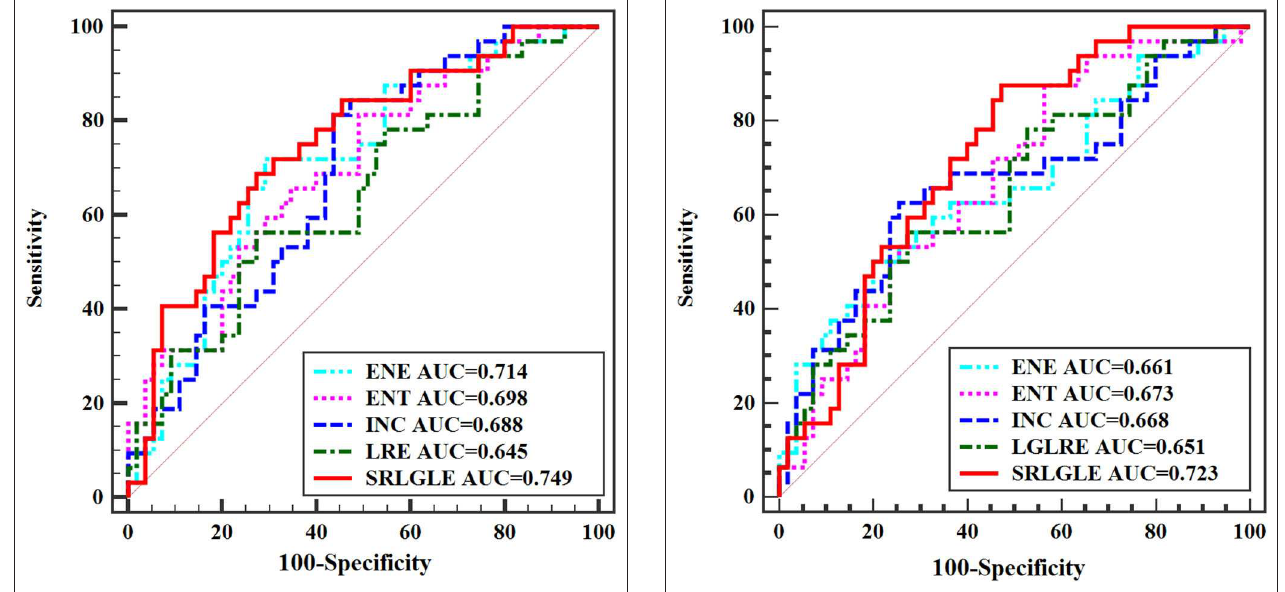
FIGURE 4 | ROC curves of statistically significant texture features extracted from oblique axial T2WI for predicting N